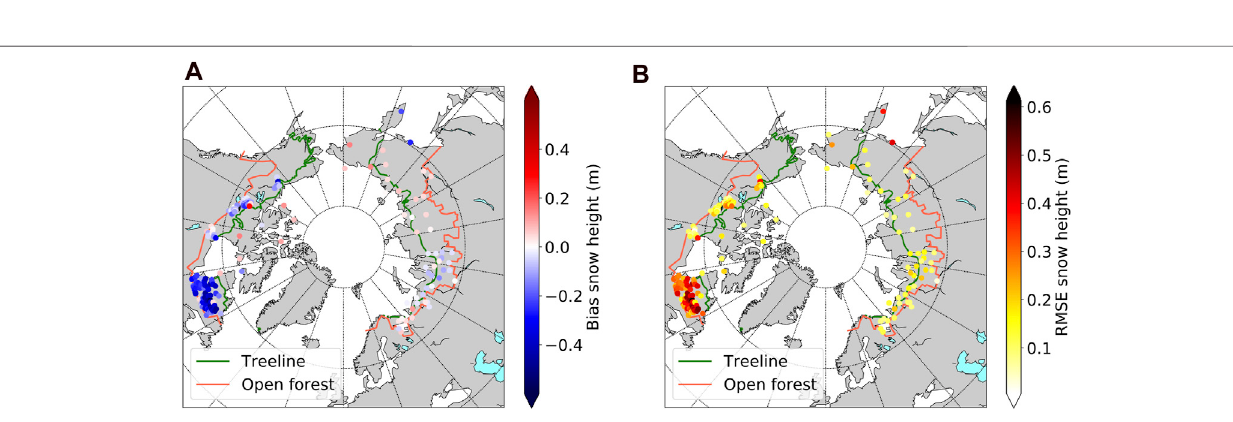
FIGURE 4 | Snow bulk density mean bias (simulations - observations) (A) and root mean square error (B) for the 39 years of simulation.